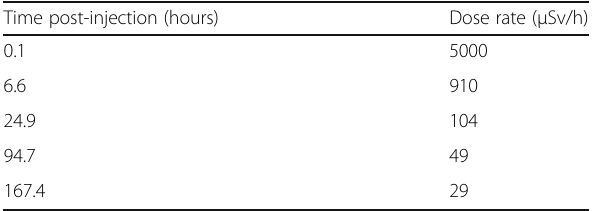
Table 1 Dose rate at contact with the injection site in the left